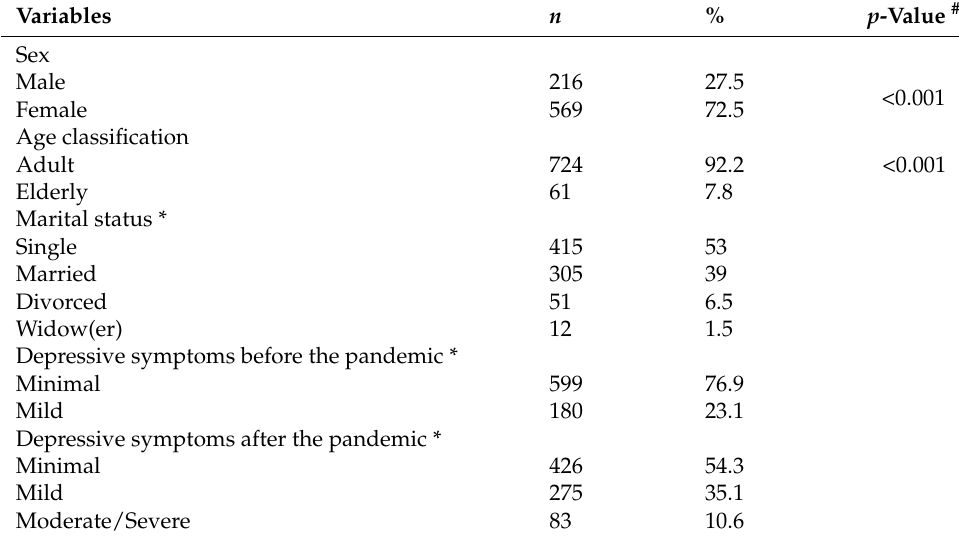
Table 1. Descriptive analysis of the study participants. ( n =